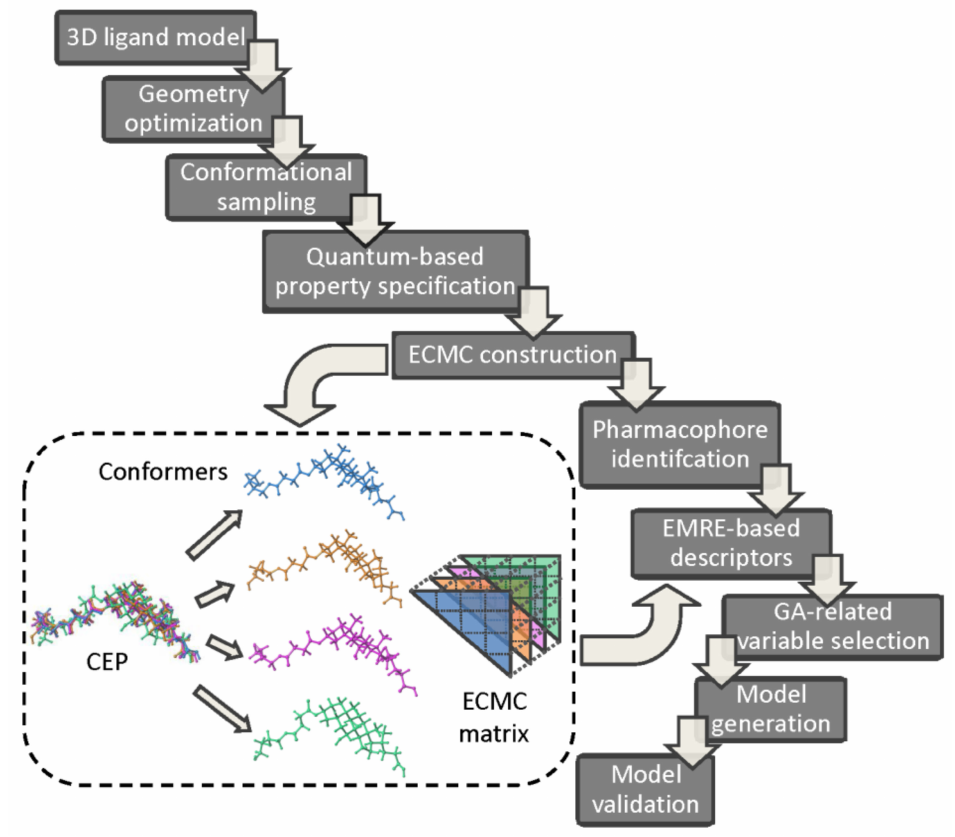
Figure 8. EC-GA 4D-QSAR operational